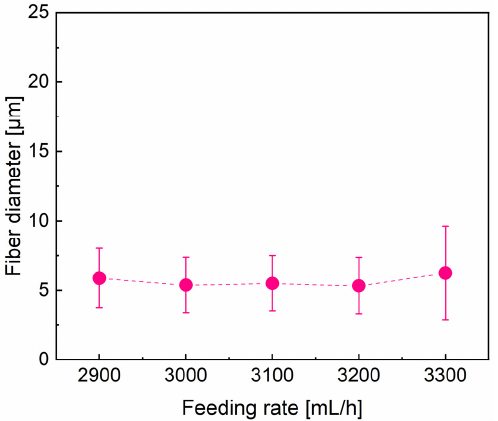
Figure 8. Tendency of average diameter of PVA fibers with the increase in feeding rate.